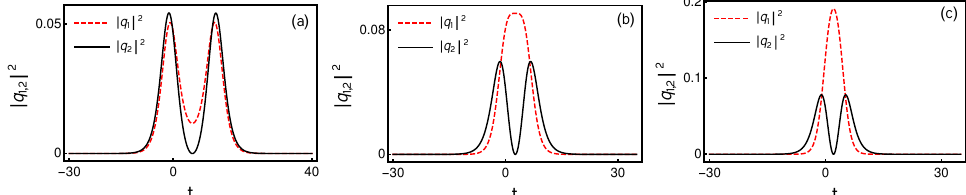
Figure 1. Symmetric intensity profiles of nondegenerate fundamental bright soliton solution (18a) and (18b): while ( a ) denotes double-hump soliton in both the modes, ( b ) represents a flat-top in q 1 mode and a double-hump in q 2 mode and ( c ) denotes a single-hump in q 1 mode and double-hump in q 2 mode. The parameter values of each figures are: ( a ): k 1 = 0.333 + 0.5 i , l 1 = 0.315 + 0.5 i , ( 1 ) = 0.425 + 0.5 i , l = 0.3 + 0.5 i , α ( 1 ) = 0.45 + 0.45 i , α ( 2 ) = 0.49 + 0.45 i . ( b ): k = 0.44 + 0.51 i α 1 1 1 1 1